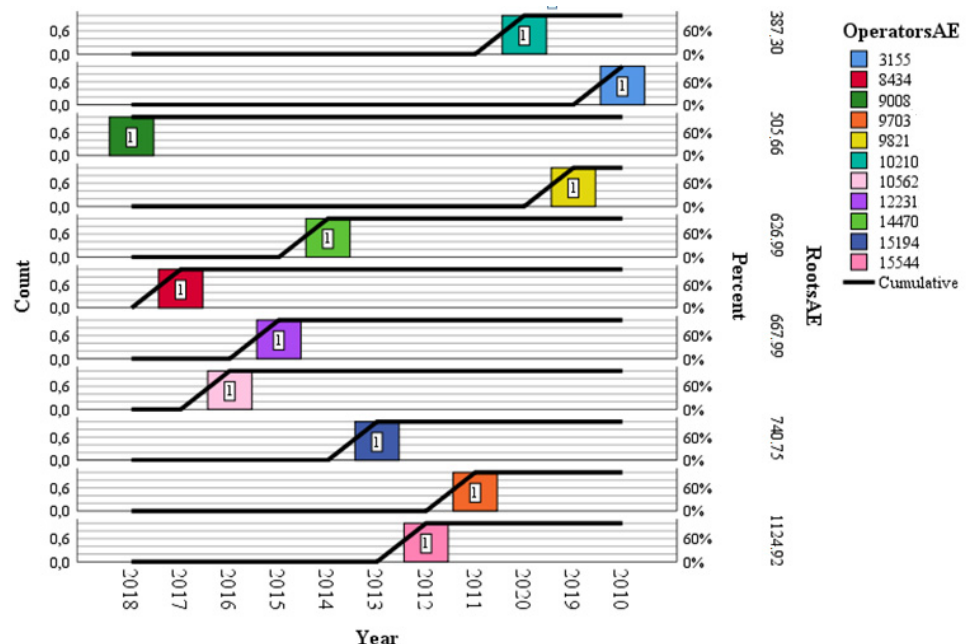
Figure 4. Pareto diagram of the evolution of the dependent variable OperatorsAE in relation to the RootsAE variable. Source: Elaborated by the authors.